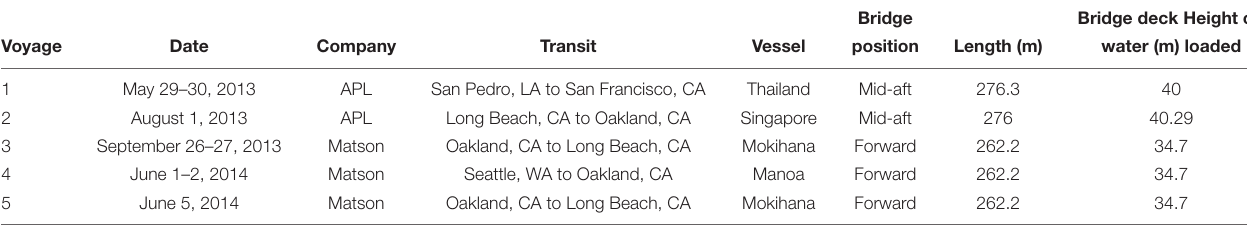
TABLE 1 | Voyage numbers, dates of travel and ship specifications of